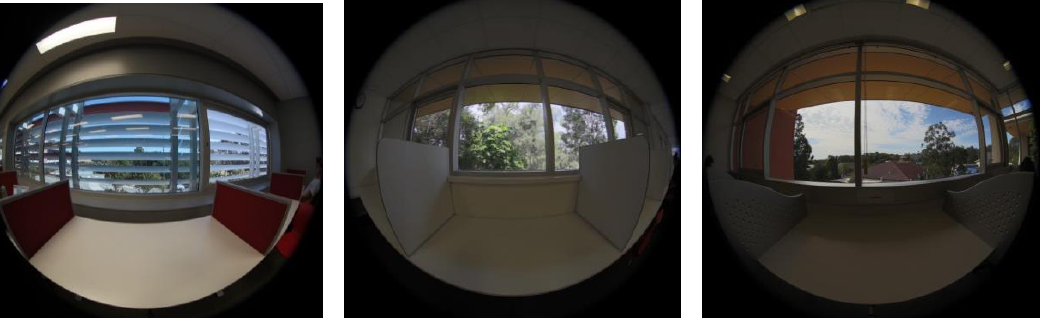
Figure 10. The workstation with most green view (left) located at 12 in Figure 5, the workstation with most sky view (middle) located at 2 in Figure 5 and the workstation with most shading view (right) located at 16 in Figure 5.